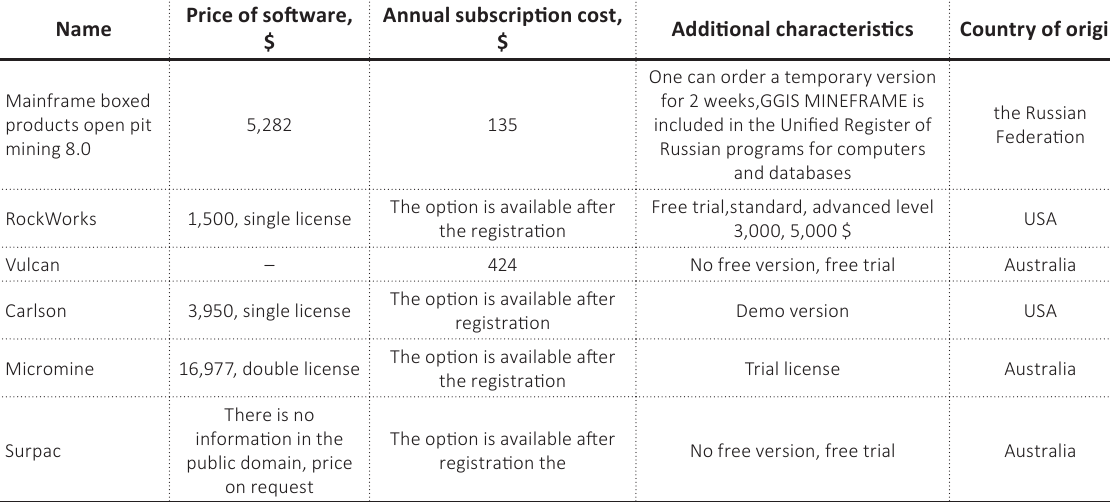
Table 3. Price proposals of typical representatives of mining design